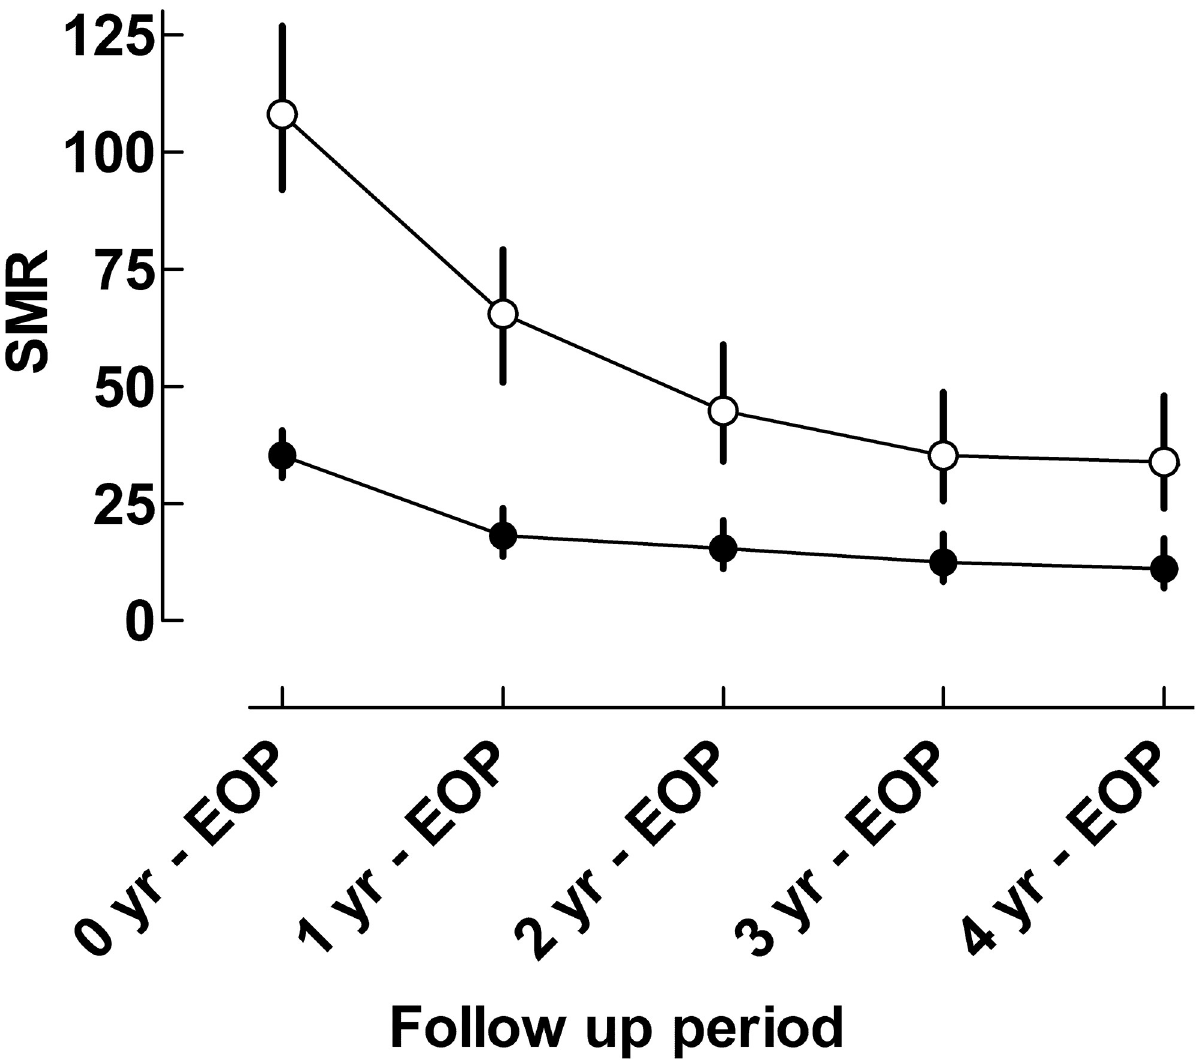
Fig 3. SMR at different time periods after PICU admission to the end of the observation period. The figure shows a comparison of SMR from patients with a single admission (Closed symbols) and repeated admissions (Open symbols). SMR expresses the mortality risk, as compared to the general population of the same age and sex. The 95% confidence intervals are given by the error bars. Statistical significances are indicated by non- overlapping confidence intervals. EOP = End of Observation Period.